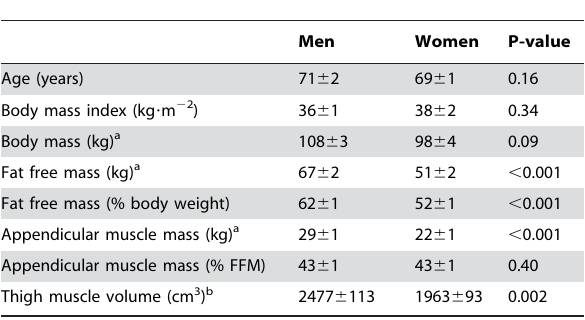
Table 1. Subject